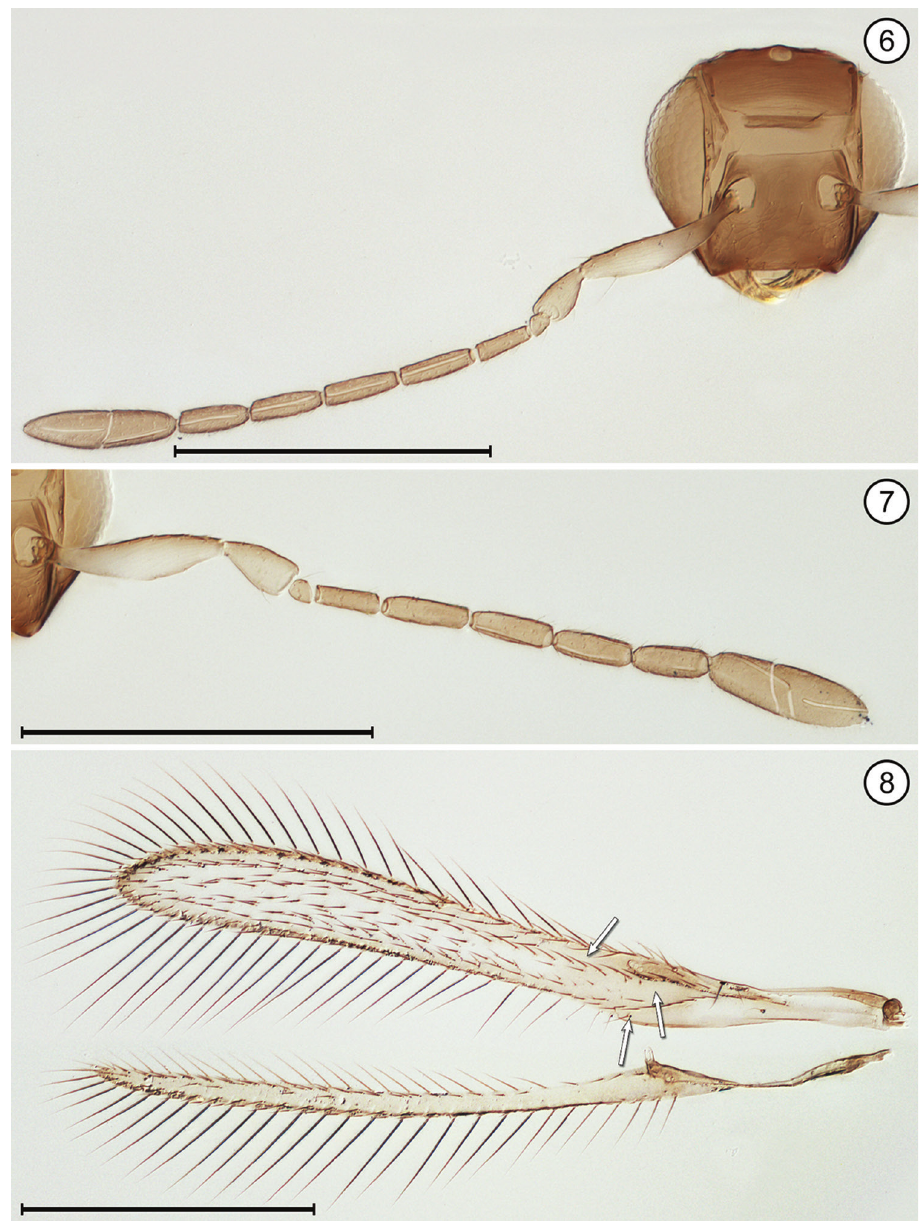
Figures 6–8. Anaphes sp., female 6 head, anterior + antenna 7 antenna 8 wings. Scale bars = 200